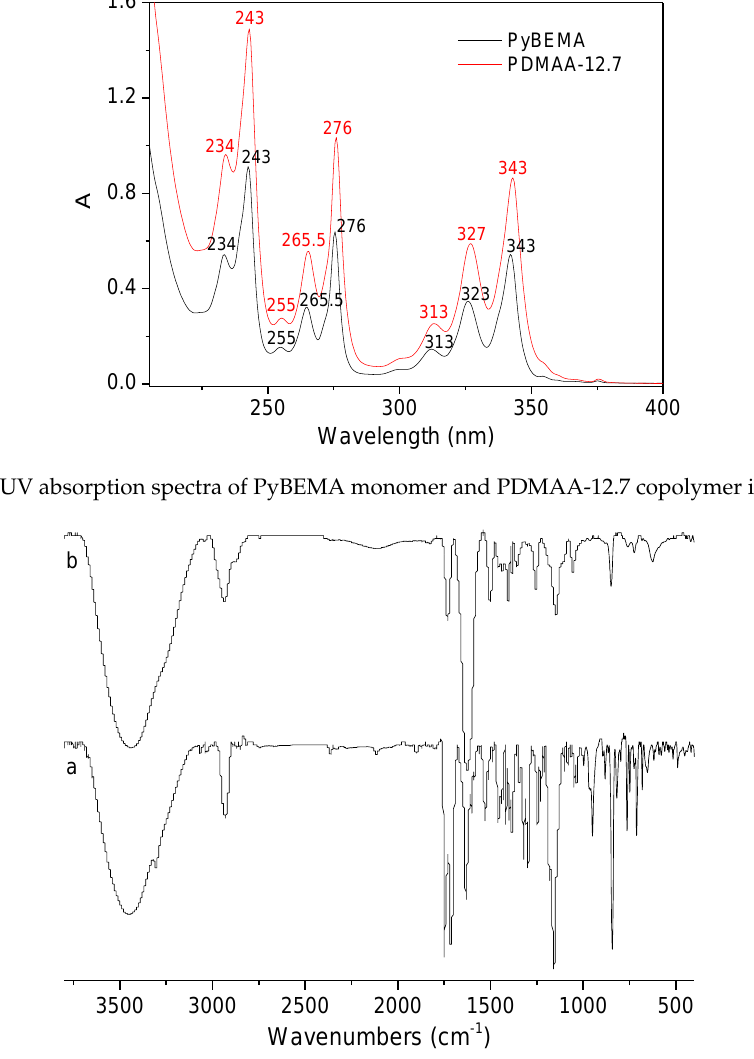
Figure 2. FT-IR spectra of PyBEMA monomer ( a ) and PDMAA-12.7 copolymer ( b ).